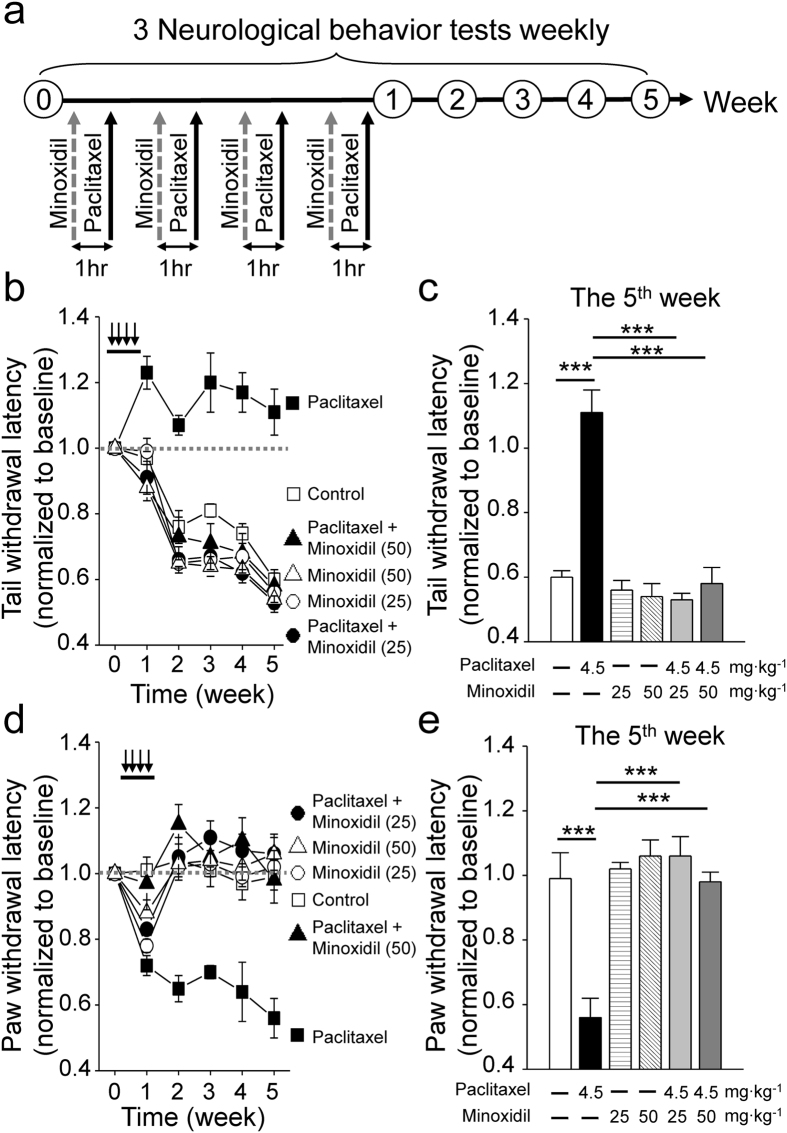
The neuroprotective effects of minoxidil in the mouse model.(a) Protocol showing drug administration and behavioral tests in the mouse model. The basal levels of each behavioral assay were obtained prior to the treatment. In the first week, 4.5 mg∙kg−1 paclitaxel was injected intraperitoneally every other day and vehicle or minoxidil (25 or 50 mg∙kg−1) was administrated by intraperitoneal injection one hour prior to paclitaxel treatment. After four courses of treatment, behavioral tests were done weekly. (b) Tail immersion test to assess thermal sensation. Y axis, normalized latency from tail immersion to tail withdrawal. Black arrow, drug infusion. (c) Quantitative analyses of tail immersion at the 5th week. Each value represents mean ± SEM from at least 7 mice in each group. ***P < 0.001 versus paclitaxel treatment, by two-way ANOVA. (d) Von Frey filament test to detect allodynia. Y axis, normalized pressure from touch to paw withdrawal. Black arrow, drug infusion. (e) Quantitative analyses of von Frey filament test at the 5th week. Each value represents mean ± SEM from at least 7 mice in each group. ***P < 0.001 versus paclitaxel treatment, by two-way ANOVA.